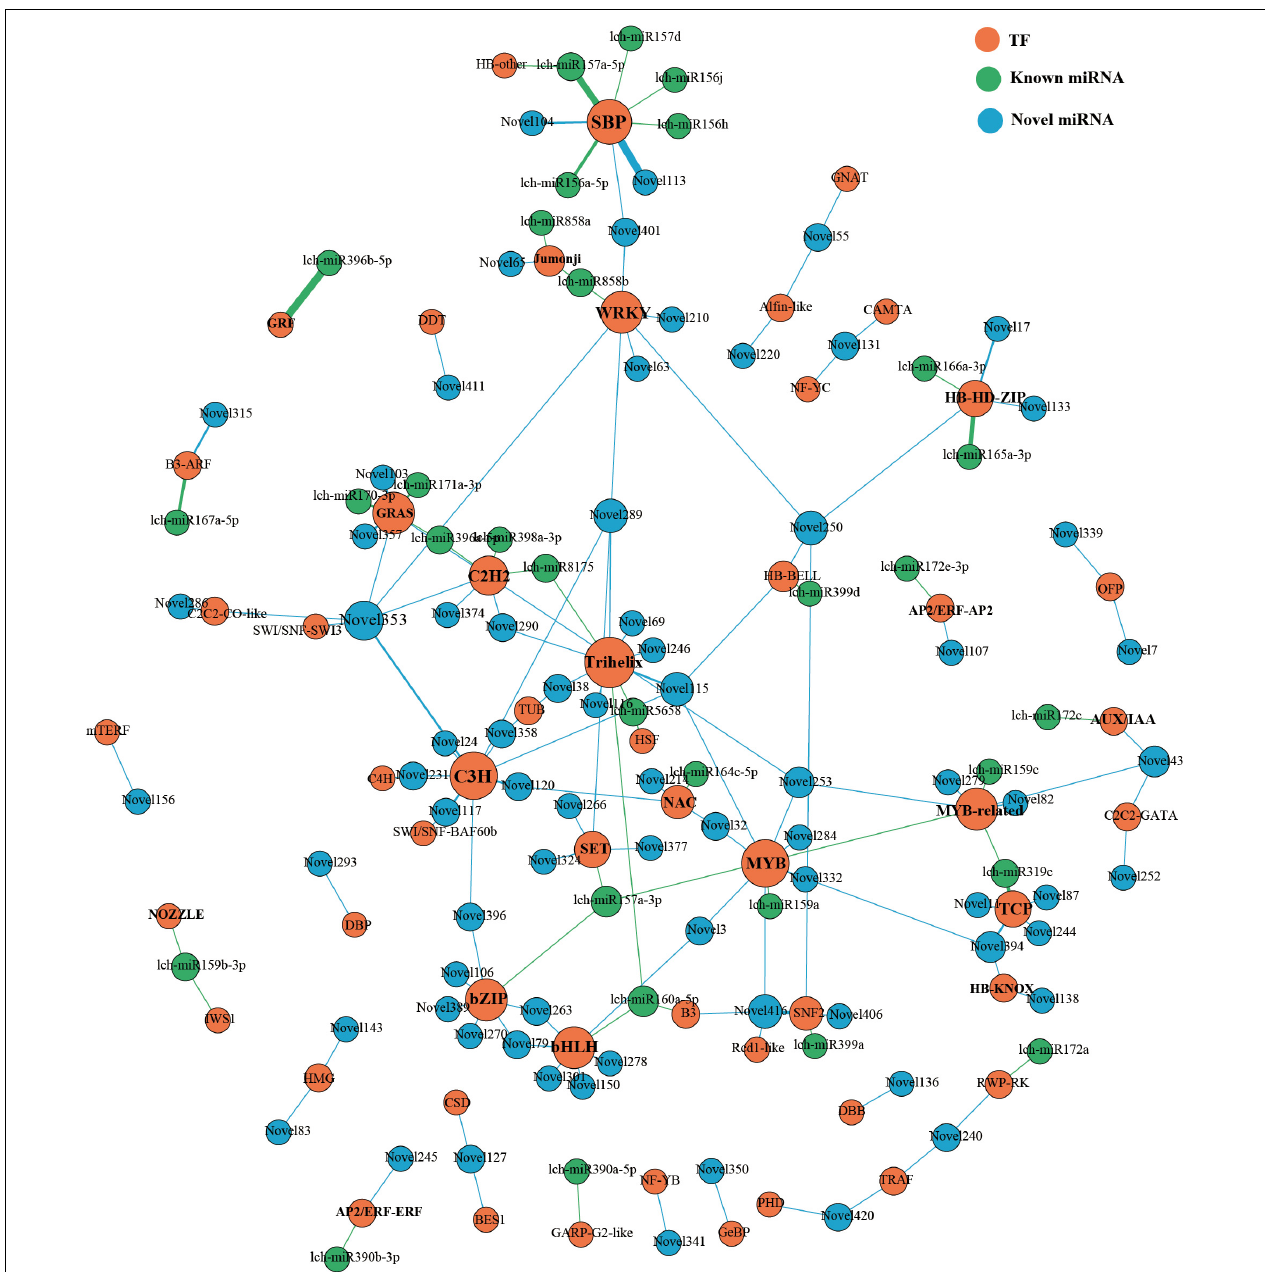
FIGURE 9 | miRNAs-TFs regulatory network of L. chinense . The size of dot represents the number of TFs: the larger the dot, the more TFs. The wider the edge, the more TFs are targeted by miRNAs.